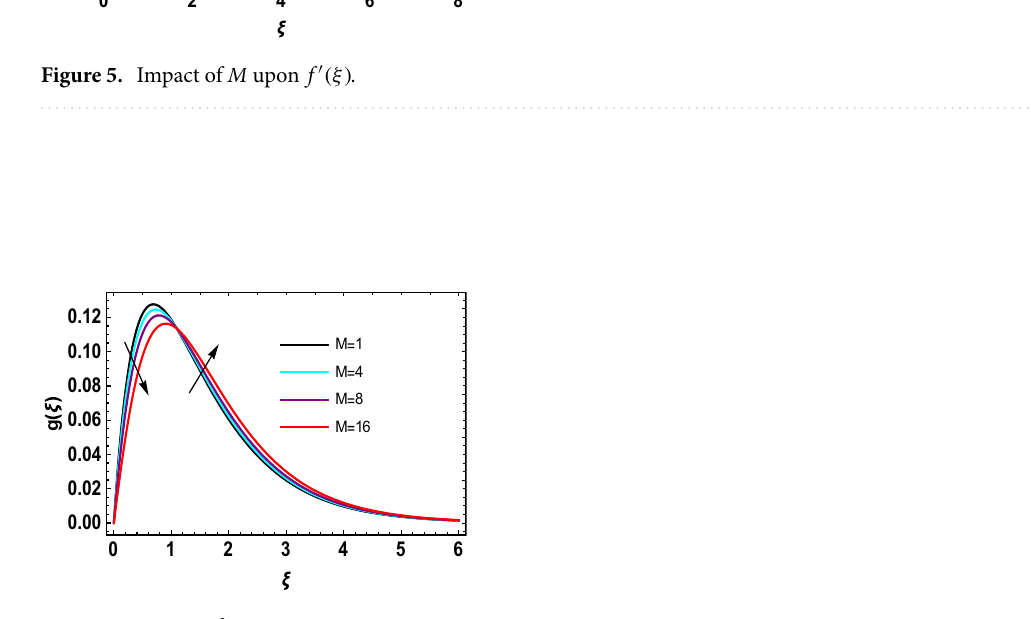
Figure 6. Impact of M upon g (ξ)